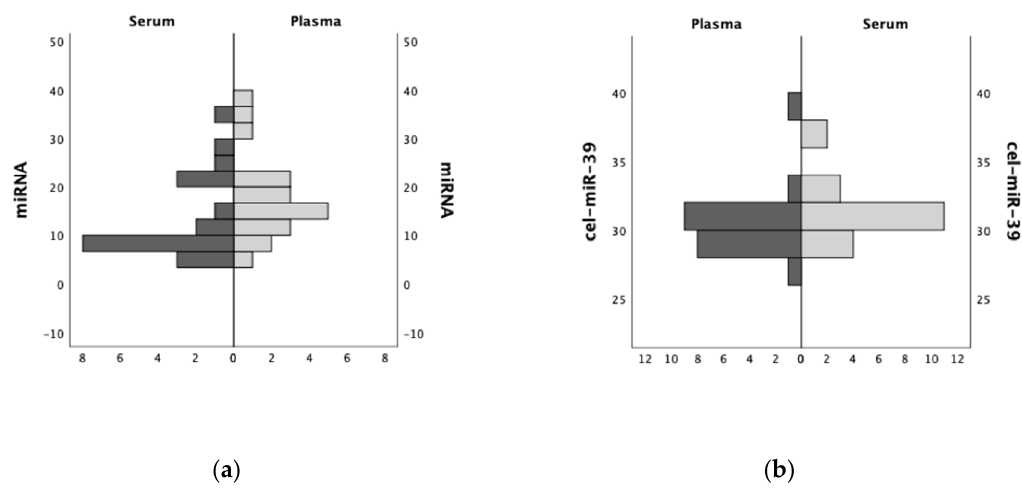
Figure 1. ( a ) Comparing total miRNA (ng/µL) concentrations and ( b ) exogenous spike-in control cel-miR-39 (Ct values) in serum and plasma samples (ranking distribution) from the same individuals.